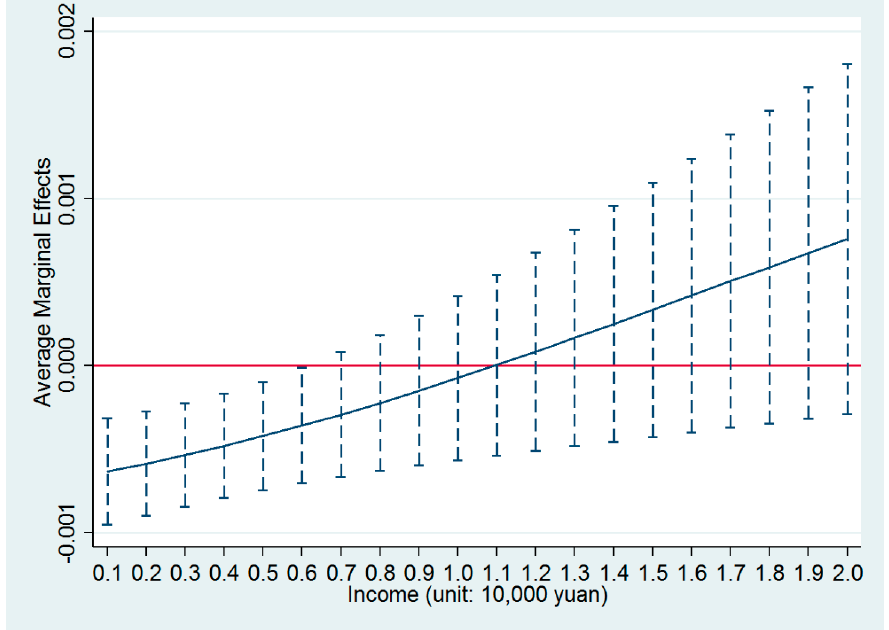
Figure 1. Average marginal effects of PM2.5 with 90% confidence intervals.